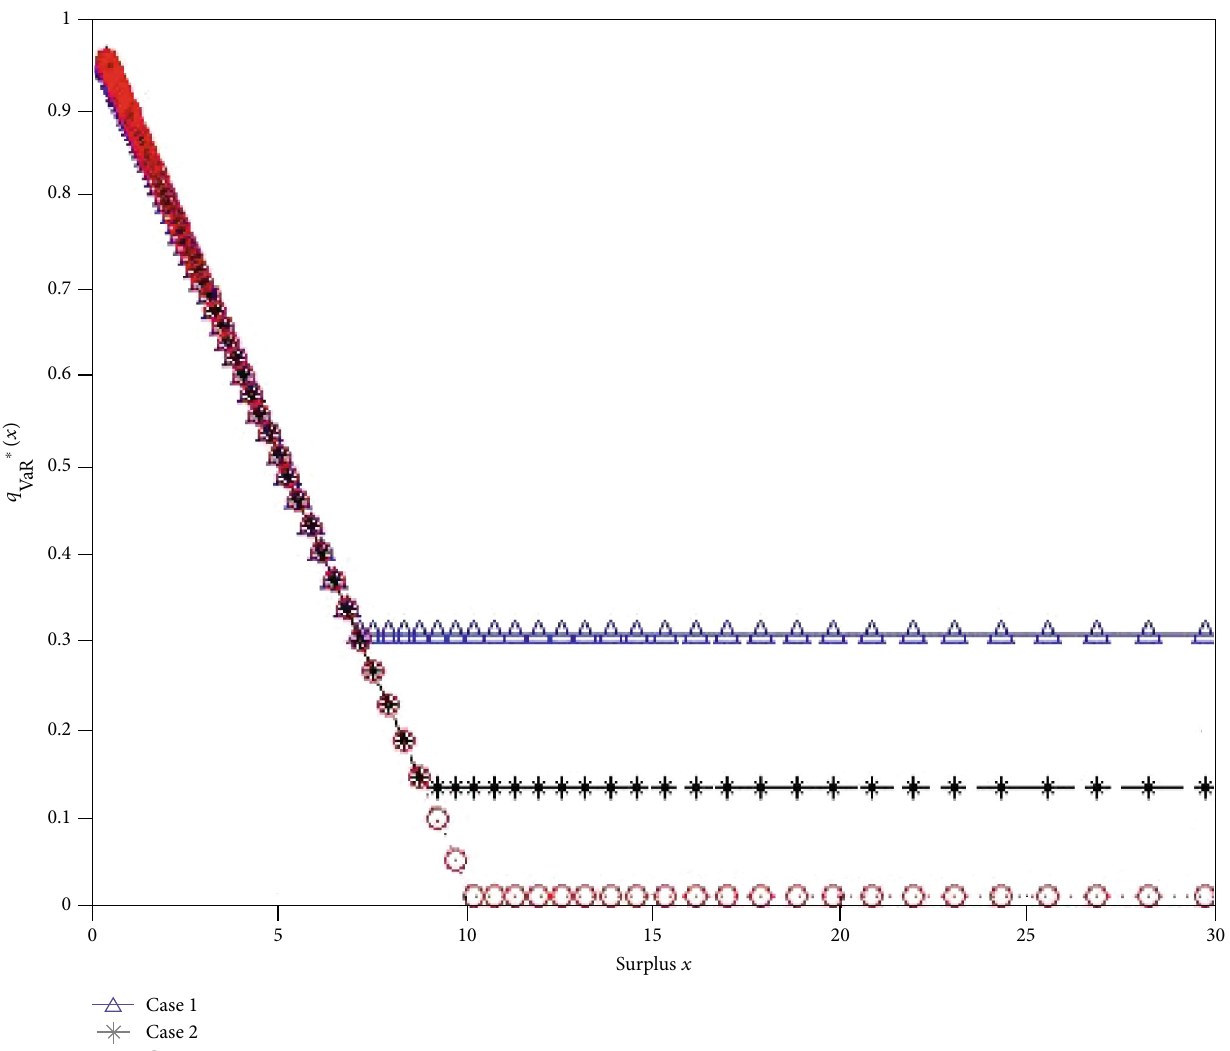
Figure 3: q ∗ ð x Þ change with x under the VaR